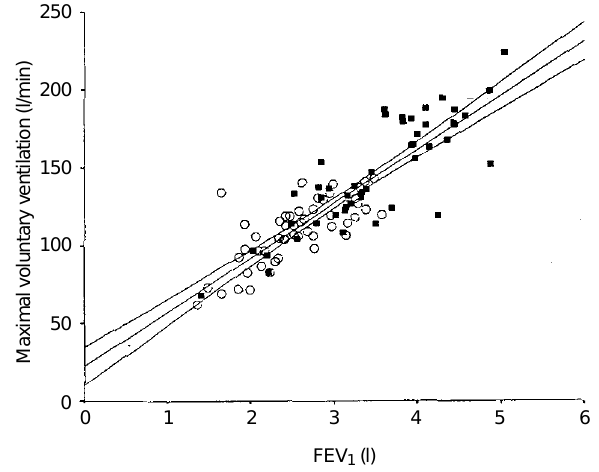
Figure 4 - Maximal voluntary ventilation (MVV) was closely correlated with the forced expiratory volume in 1 s (FEV 1 ) but with a positive y- intercept: MVV (l/min) = 37.5 (FEV 1 ) + 15.8, R 2 = 0.817, SEE =